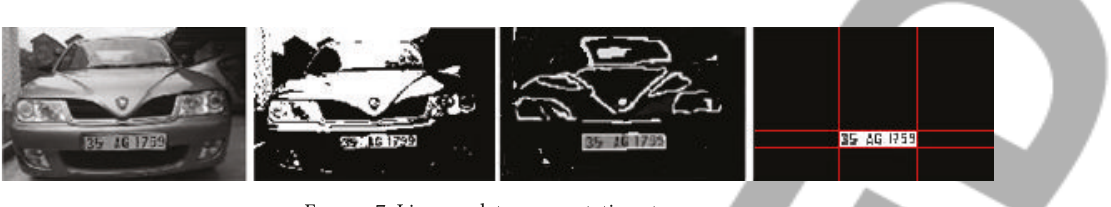
Figure 7: License plate segmentation